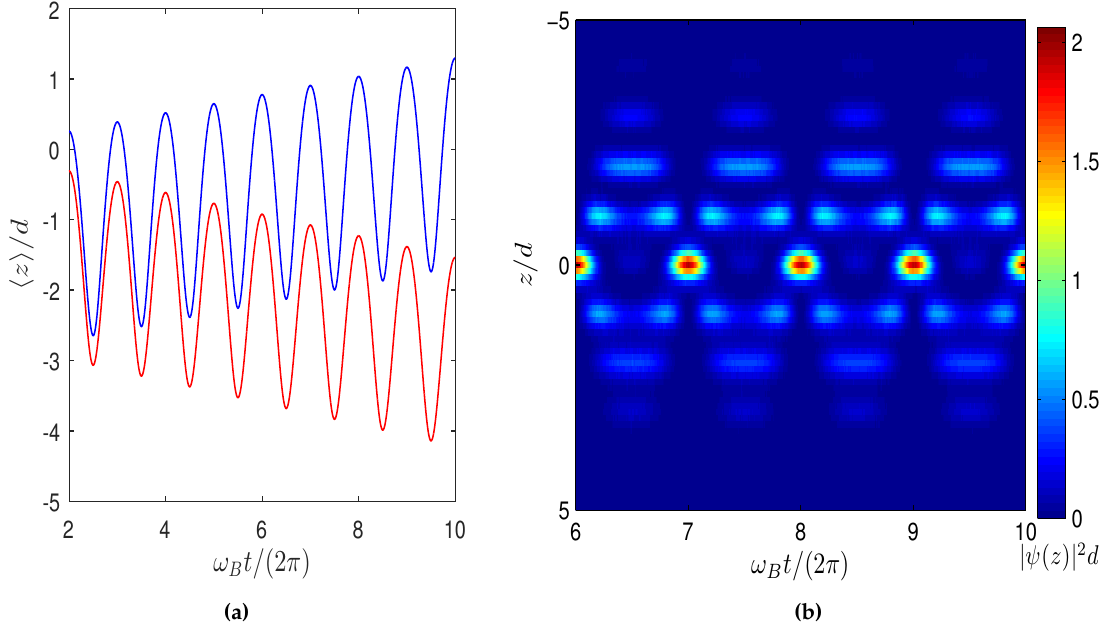
Figure 2. Backaction-induced atomic transport and breathing dynamics in a cavity with U 0 = NU 0 = 2 π 2 π 1 Hz, κ = 1 kHz and Bloch frequency ω B = 2 π − × − × ( a ) Condensate centroid position as a function of time showing uphill (blue, ∆ c NU 0 = and downhill (red, ∆ c 0.7 κ ) transport for an initial atomic wave packet delocalised − − over 20 lattice sites; ( b ) breathing dynamics of the condensate density at the Bloch period for ∆ c − NU 0 = − 0.7 κ and an initial atomic wave packet localised within one lattice